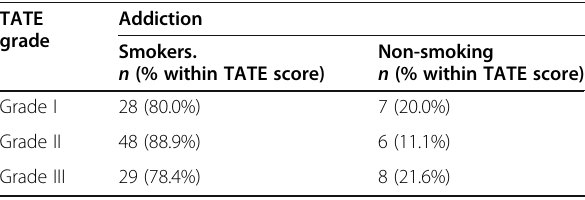
Table 2 Showing association between habit of smoking